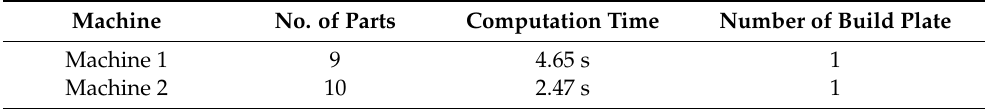
Table 3. Computation results of the case study.